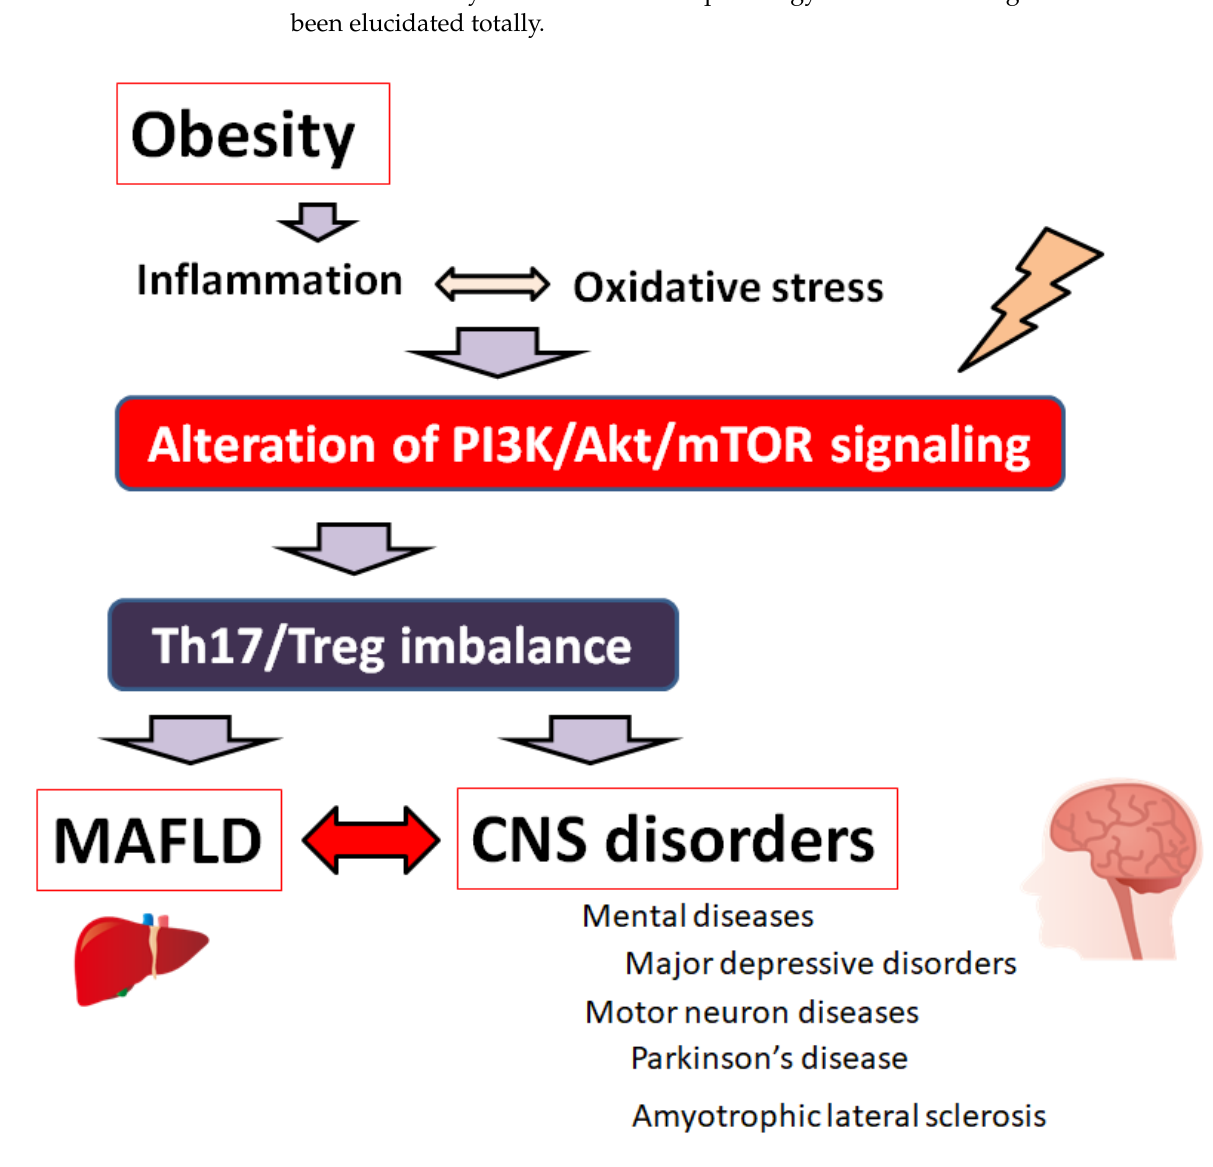
Figure 1. A hypothetical schematic representation and overview of the pathogenesis of MAFLD and various brain disorders including mental diseases and/or motor neuron diseases. Obesity, inflammation, and/or oxidative stress could lead to the alteration of PI3K/AKT/mTOR signaling following contribution to the imbalance of Th17/Treg ratio of immune cells, which might eventually lead to the pathogenesis both of MAFLD and brain disorders. Note that several significant things have been omitted for clarity.